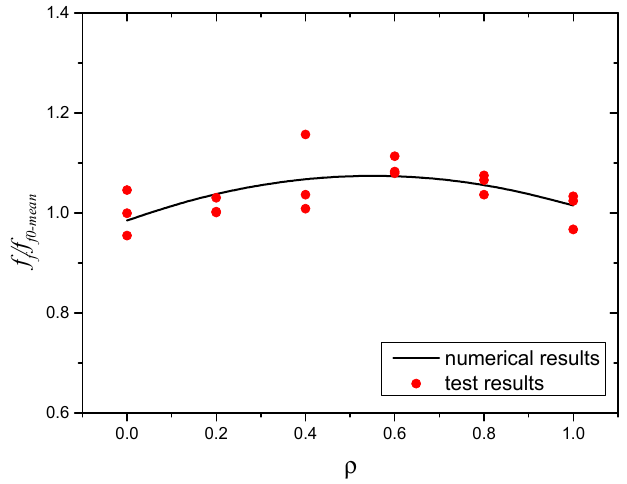
Figure 23. Comparison between numerical and test results: f f .